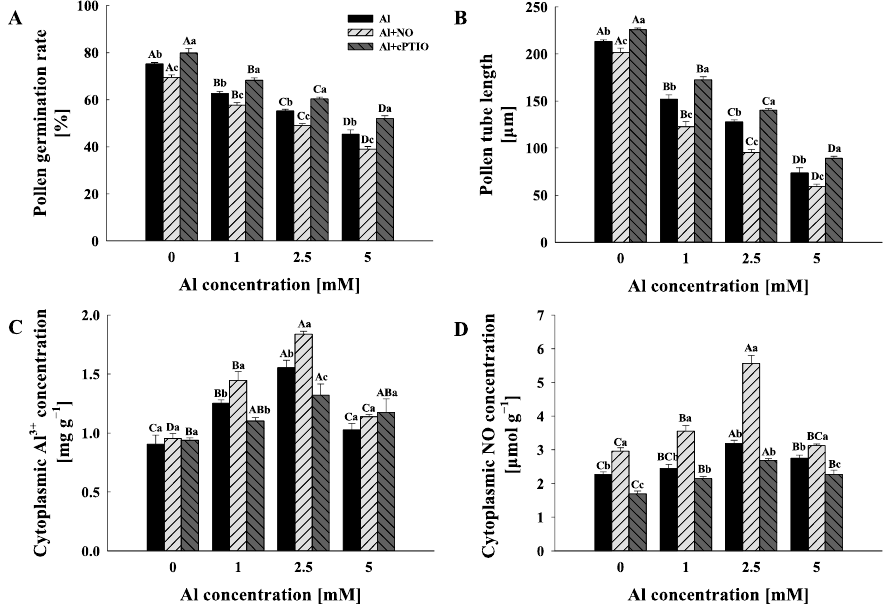
Figure 1. The effects of different treatments on the pollen germination rate ( A ), pollen tube length, ( B ) cytoplasmic Al 3+ concentration, ( C ) and cytoplasmic NO concentration ( D ) of Camellia sinensis . Al represents the treatment group treated with Al concentration gradient only, Al + NO represents the treatment group treated with Al 3+ concentration gradient treatment and 25 μM DEA NONOate (NO donor), and Al + cPTIO represents the treatment group treated with Al 3+ concentration gradient treatment and 200 μM carboxy PTIO potassium salt (NO scavenger). Different lowercase letters represent significant differences among different nitric oxide conditions under the same Al 3+ concen- tration treatment, and different uppercase letters represent significant differences among different Al 3+ concentration treatments under the same nitric oxide conditions (for pollen germination rate and pollen tube length, n = 10, and for cytoplasmic Al 3+ and NO, n = 3, p < 0.05), as determined by the Duncan test.